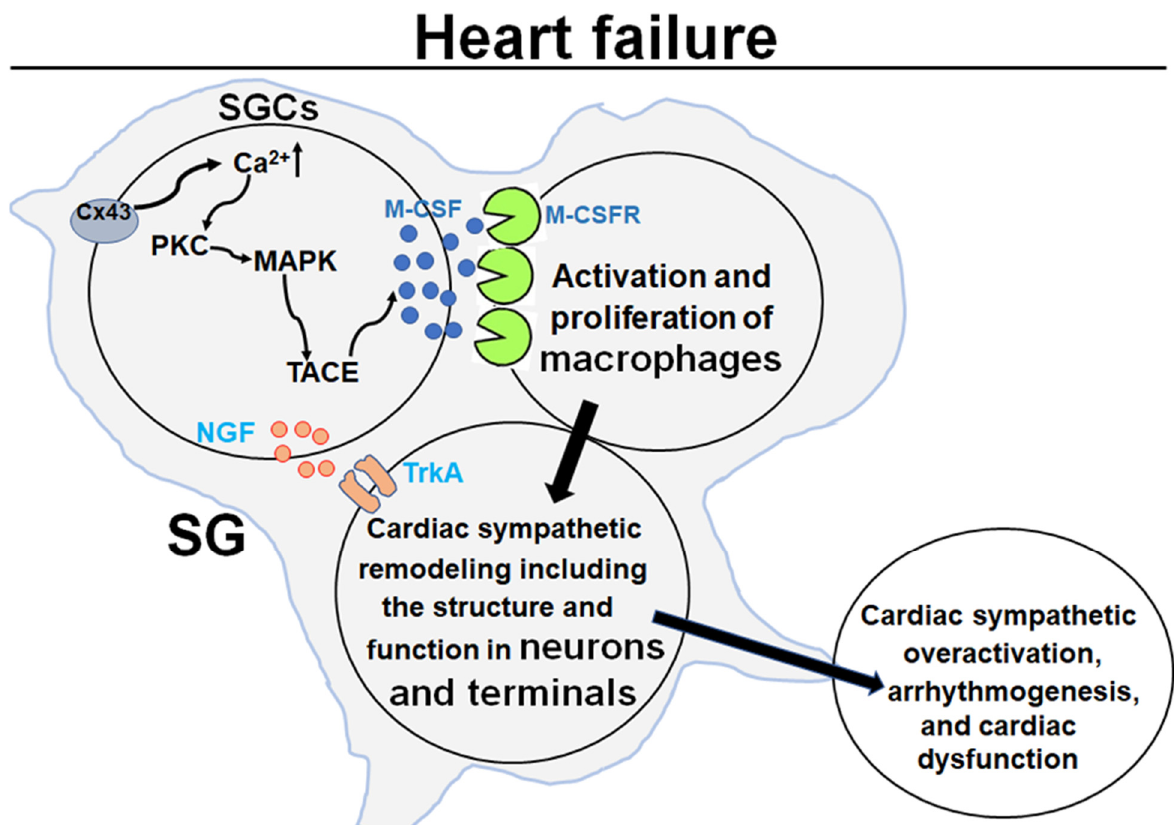
Figure 2. Mechanisms underlying the remodeling of cardiac postganglionic sympathetic neurons in HF. SGC: satellite glial cell; Cx43: connexin 43; PKC: protein kinase C; MAPK: mitogen-activated protein kinase; TACE: tumor necrosis-converting enzyme; M-CSF; macrophage colony-stimulating factor; M-CSFR: macrophage colony-stimulating factor receptor; NGF: nerve growth factor; TrkA: tropomyosin receptor kinase A; SG: stellate ganglion. Funding: This study was supported by the National Institute of Health’s National Heart, Lung,